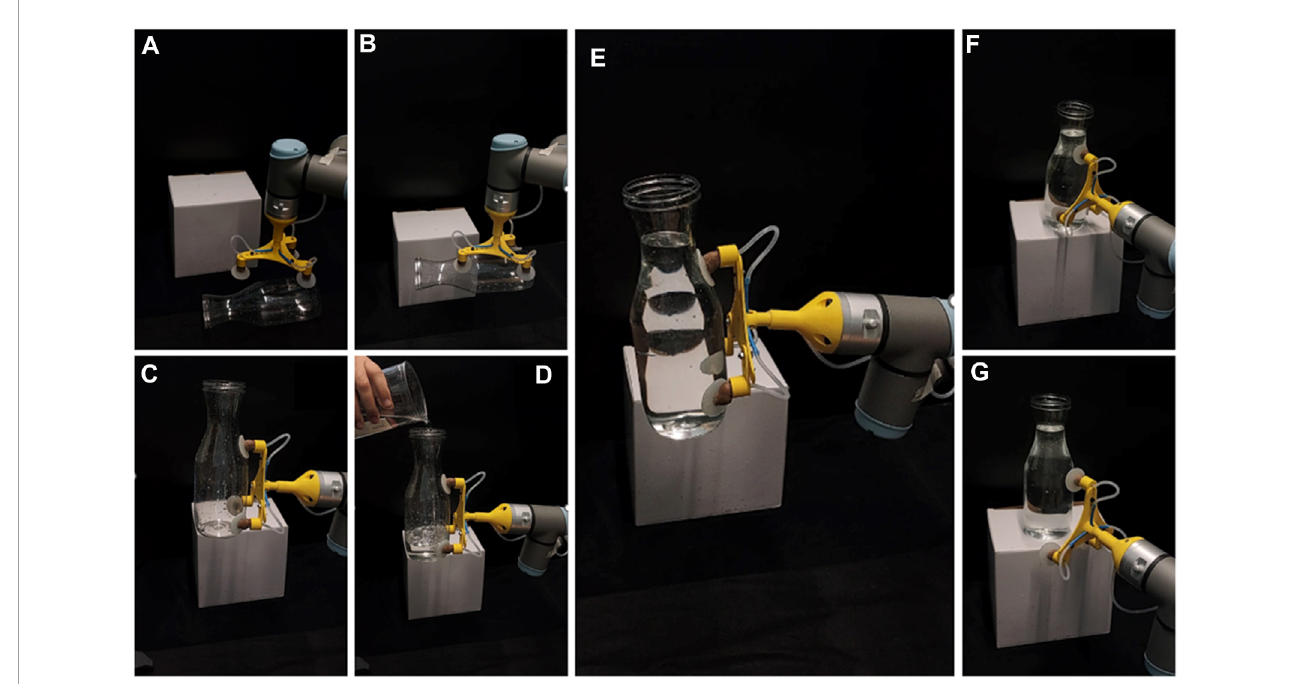
FIGURE 10 (A–C) adaptation to the angular surfaces of a bottle, (D) adding lateral load by pouring water (E) holding 1,028 g of lateral load (F–G) manipulation and releasing the